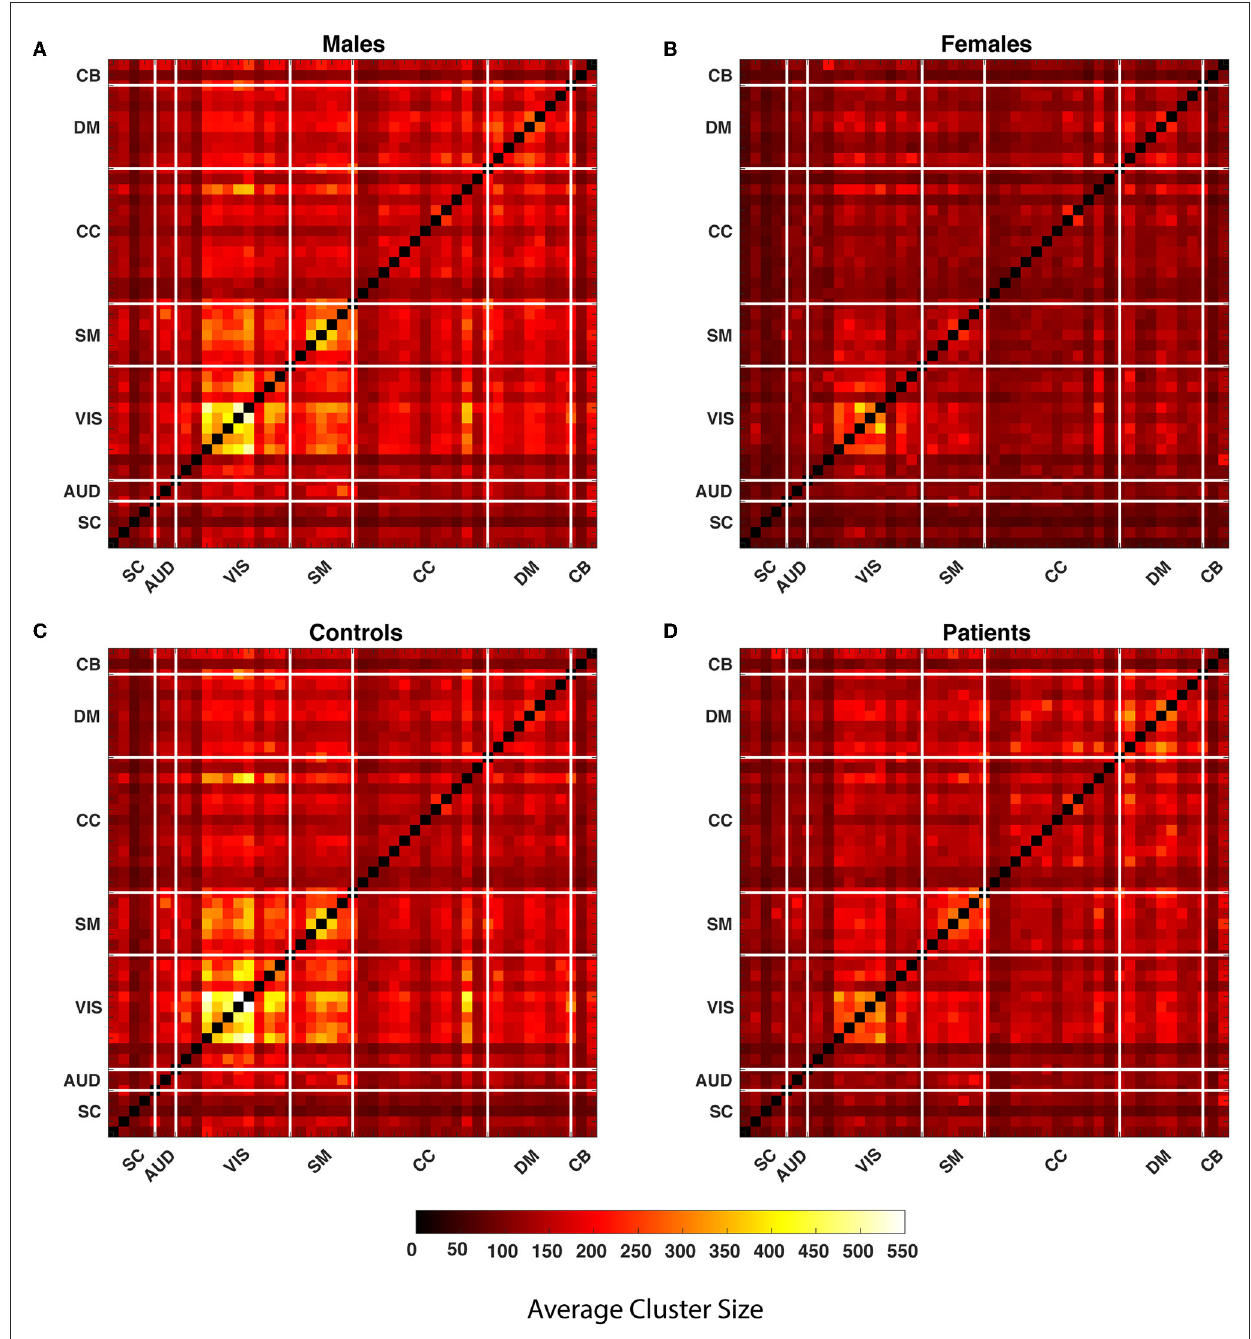
FIGURE4 The average cluster size is calculated throughout all WW correlation maps for each quartile within the subgroups. In the figure, each cell of the matrices represents the average cluster size of a particular component pair for the subgroups. The matrices represent the average cluster size of the male, female, healthy controls and people with schizophrenia in the last quartile from (A–D) . The thick white lines split the map into regions for seven distinct networks defined in the methods section.